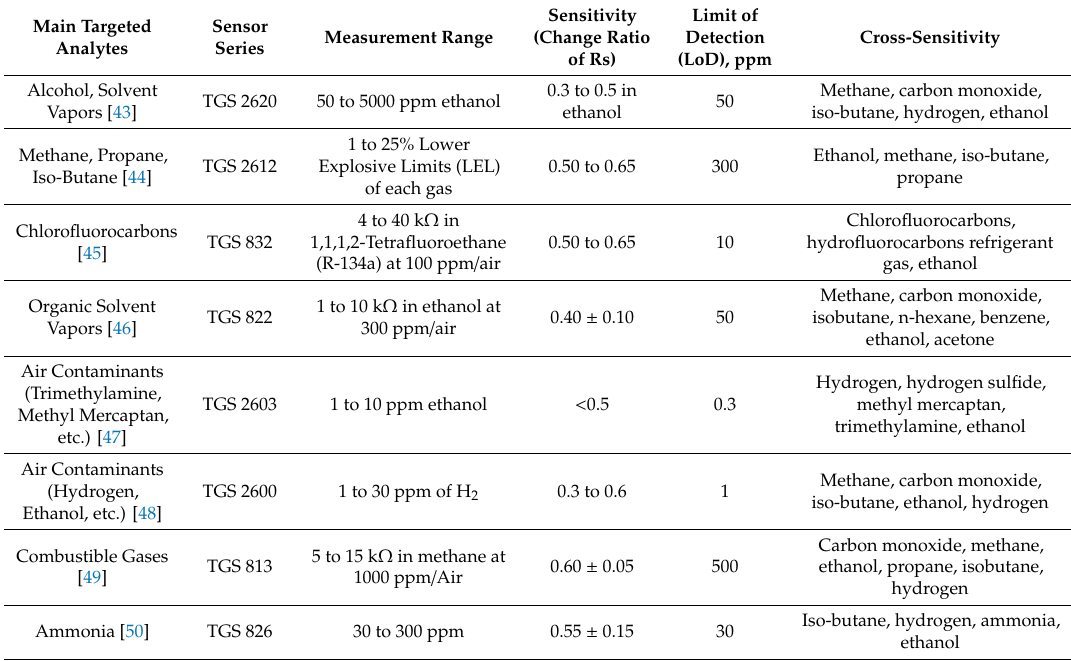
Table 2. List of sensors used in the